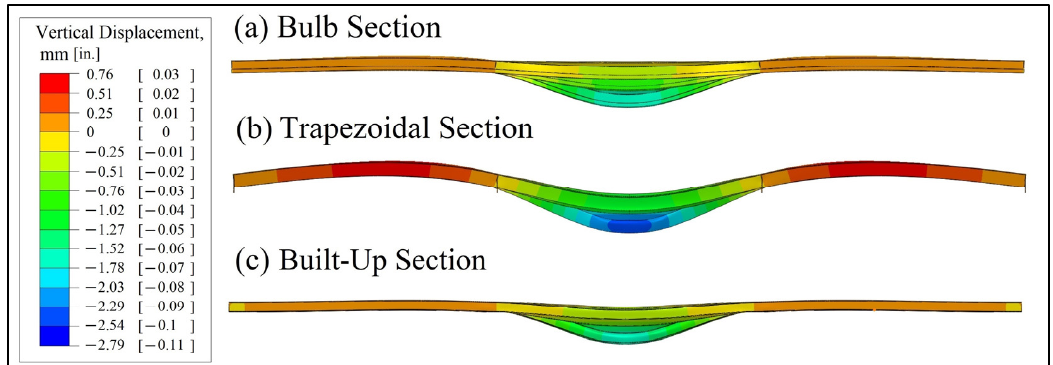
Figure 16. Continuum case 1 scaled deflection shapes due to rear load.